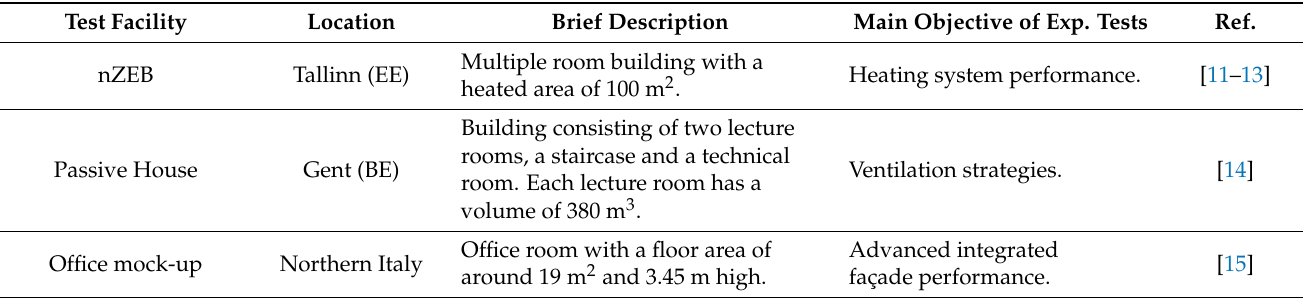
Table 1. Examples of European test facilities for building performance